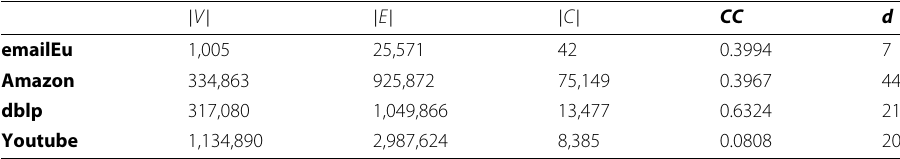
Table 1 Datasets